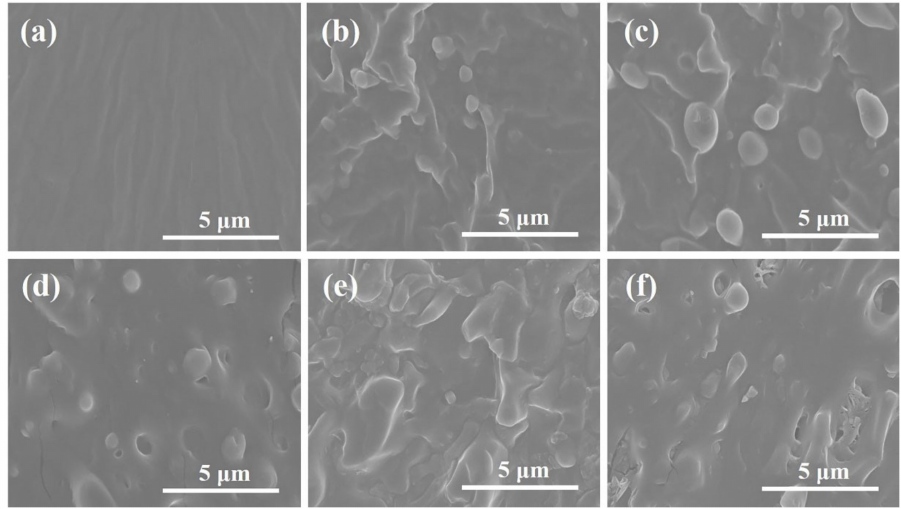
Figure 3. Scanning electron microscope images of various MPU/EUG composites: ( a ) pure MPU; ( b ) MPU/EUG = 90/10; ( c ) MPU/EUG = 80/20; ( d ) MPU/EUG = 70/30; ( e ) MPU/EUG = 60/40; ( f ) MPU/EUG =